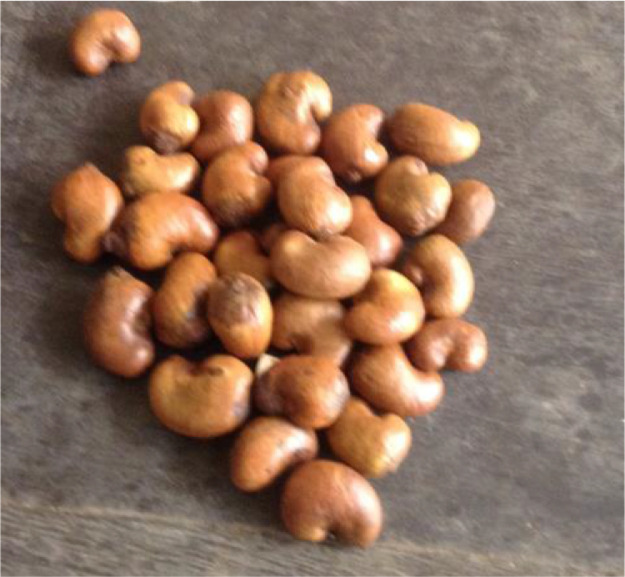
Roasted cashew nuts.